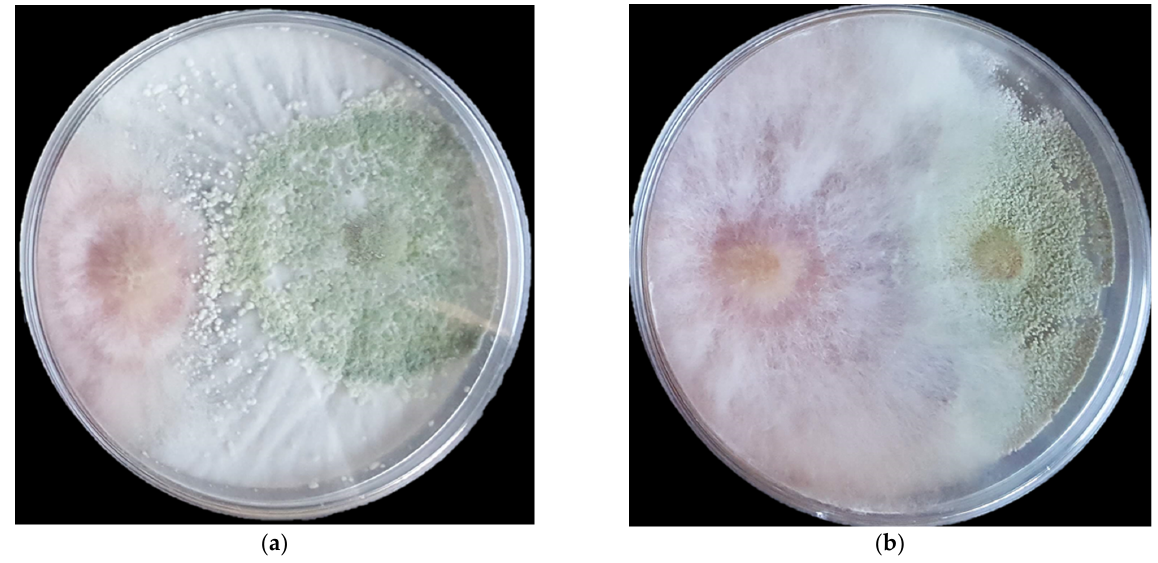
Figure 2. Direct confrontation of F. culmorum with ( a ) T. hamatum T311 (65.8% of growth inhibition) and ( b ) T. rossicum T328 (49.7% of growth inhibition) . In the image, Fusarium sp. is on the left, and and ( b ) T. rossicum T328 (49.7% of growth inhibition). In the image, Fusarium sp. is on the left, and Trichoderma spp. is on the right. Trichoderma spp. is on the